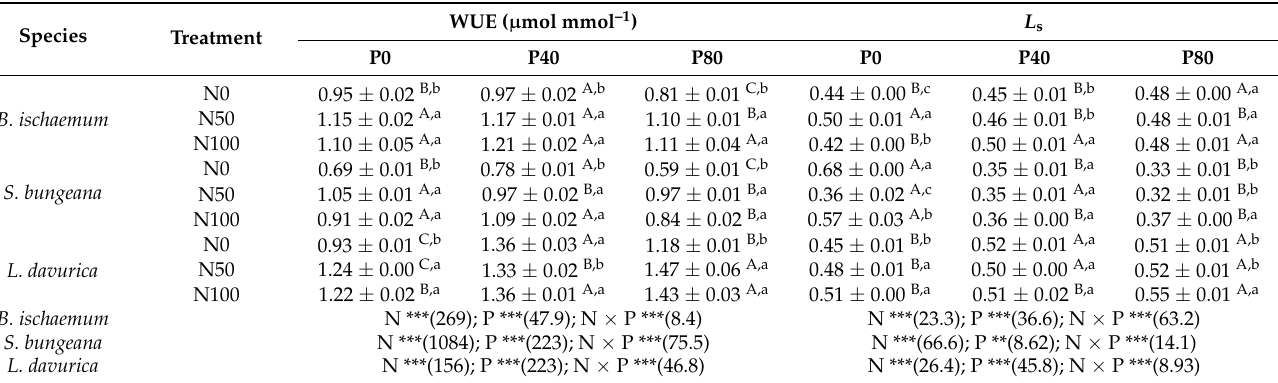
Table 1. Instantaneous water use efficiency (WUE) and stomatal limitation value ( L s ) of the three species under different N and P additions (mean ± SD, n = 3).